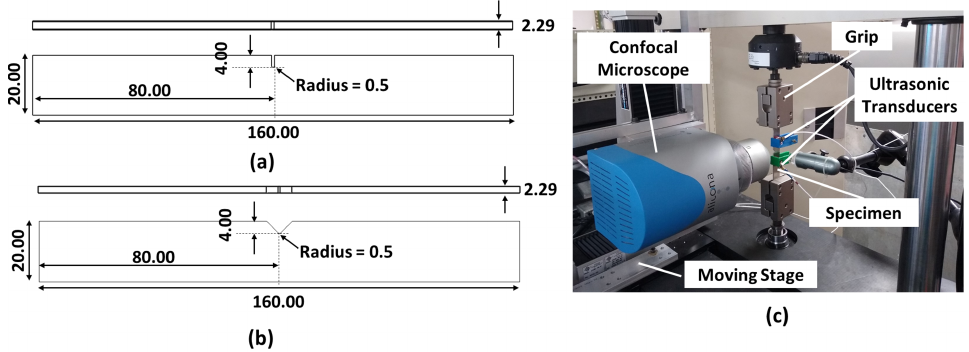
Figure 2. Schematic of ( a ) a U-notch and ( b ) a V-notch specimen. All dimensions are in mm. ( c ) The experimental setup for fatigue